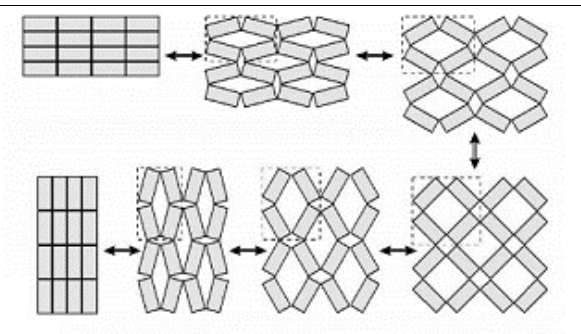
Figure 10. Newtonian or auxetic behaviour of rotating rectangles cellular